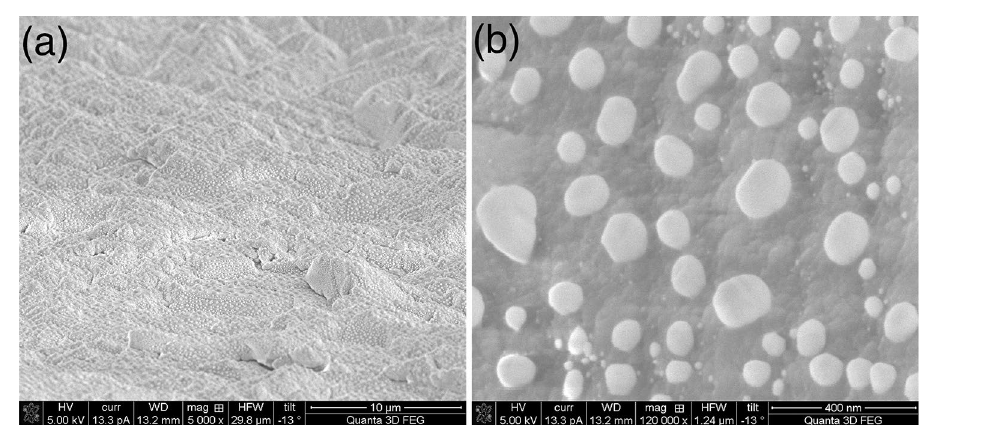
Figure 2. ( a ) SEM image showing the Au nanomask on a large, unpolished area of sapphire substrate; ( b ) a close-up showing the distribution in size and position of Au nanomask